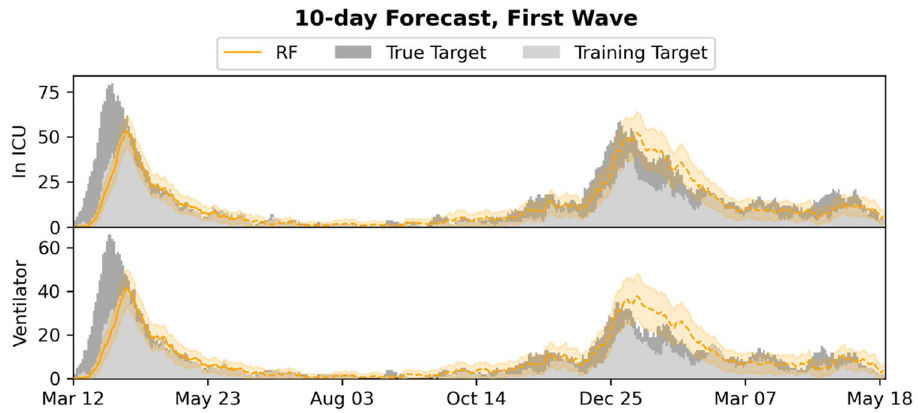
Figure 7. 10-day forecasts of admission to ICU and use of mechanical ventilation, compared to the training and true targets in the first wave setting. Predictions and targets for both the first wave (training data) and the subsequent waves (test data, dashed) are shown, as well as the 95% confidence